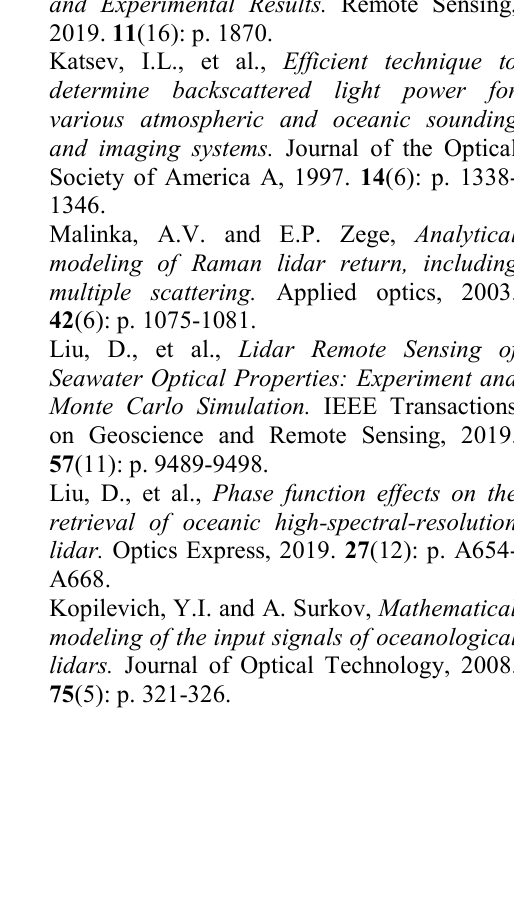
Fig. 5. Phase function effects on the lidar attenuation coefficient under (a) Case A (clear ocean, FOV of 50 mrad), (b) Case B (coastal ocean, FOV of 50 mrad) and (c) Case C (coastal ocean, FOV of 200